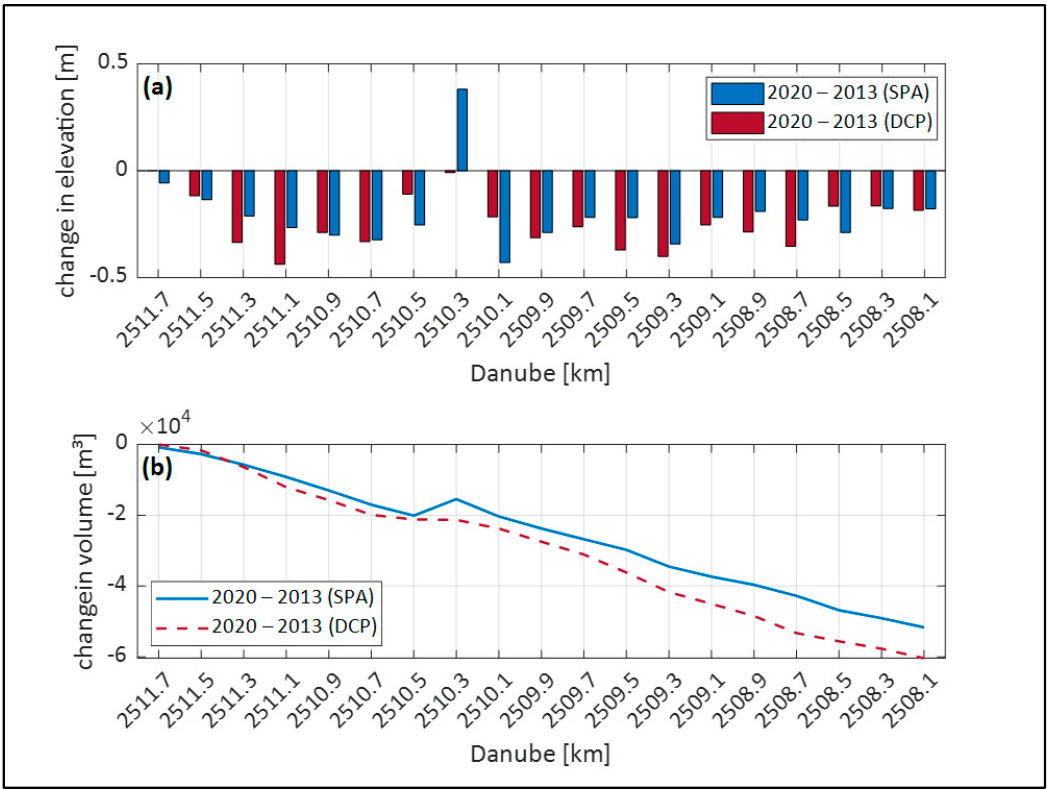
Figure 5. Comparison of change in elevation of SPA and DCP data for 2020–2013 ( a ) and comparison of the accumulated change in volume for 2020–2013 ( b ).